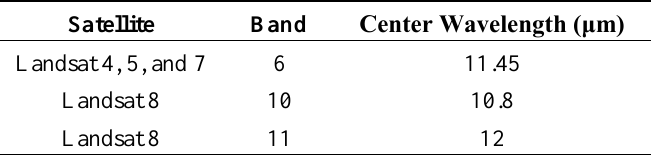
Table 3. Center wavelength for Landsat satellites.